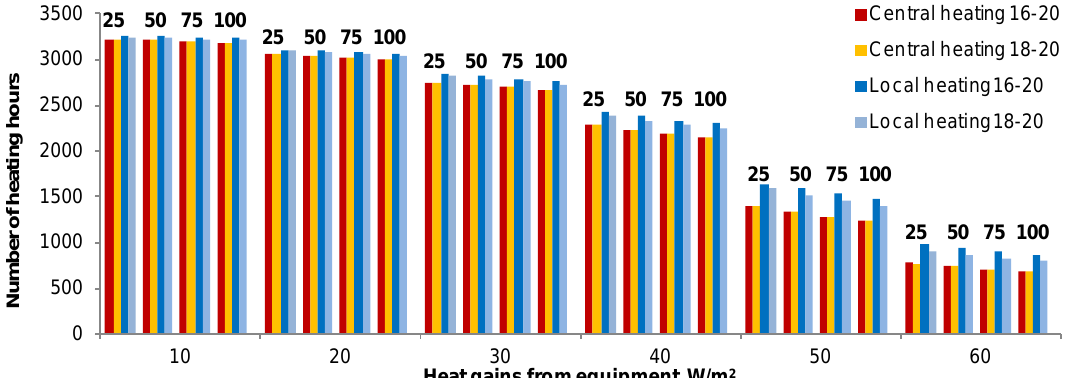
Figure 4. Number of hours for the entire hall or just workplaces heating from 16 to 20 °C or 18 to 20 °C with central and local systems for all the cases investigated (number of workplaces are indicated above bars).